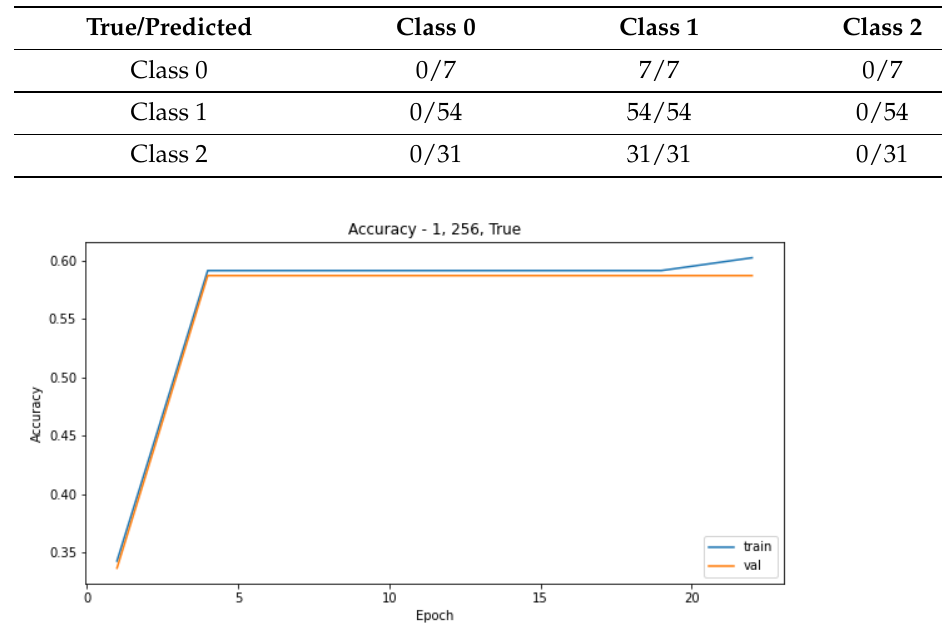
Figure 3. Model accuracy for the training and validation sets in relation to different number of epochs used to train the CNN.